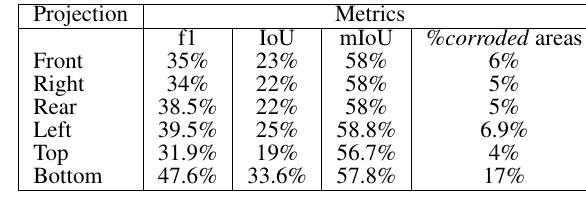
Table 4. Performance per cube